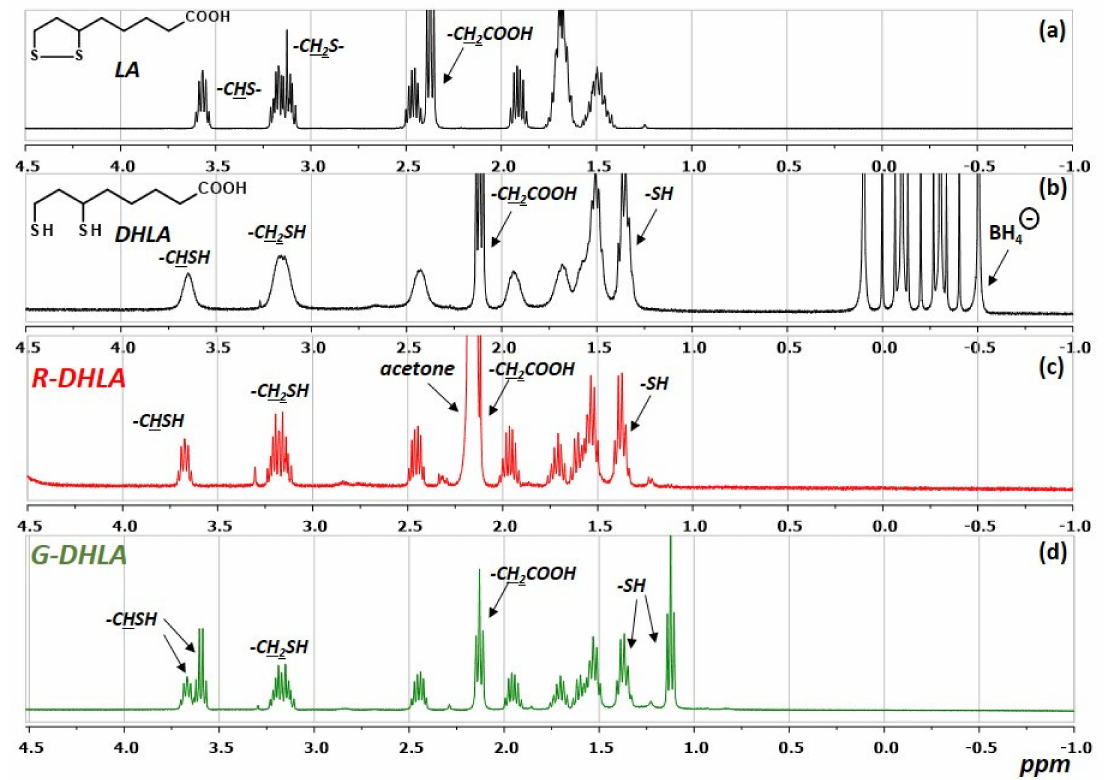
Figure 4. 1 H NMR spectra of lipoic acid ( LA ) (in CDCl 3 ) ( a ) and DHLA (in D 2 O) ( b ) and D 2 O dispersion of AgInS 2 -ZnS nanocrystals capped with DHLA : R-DHLA ( c ) and G-DHLA ( d